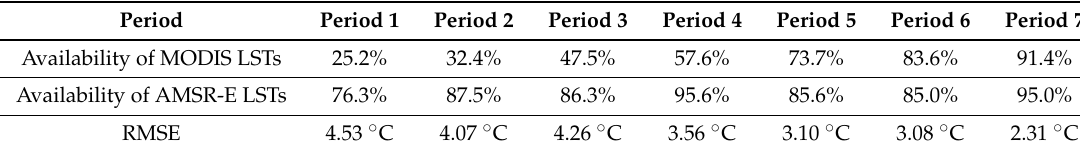
Figure 9. Comparison of the adjusted station measurements with the corresponding merged LSTs for different periods (from period 1 to 7). Table 5. Validation of the merged LSTs for each